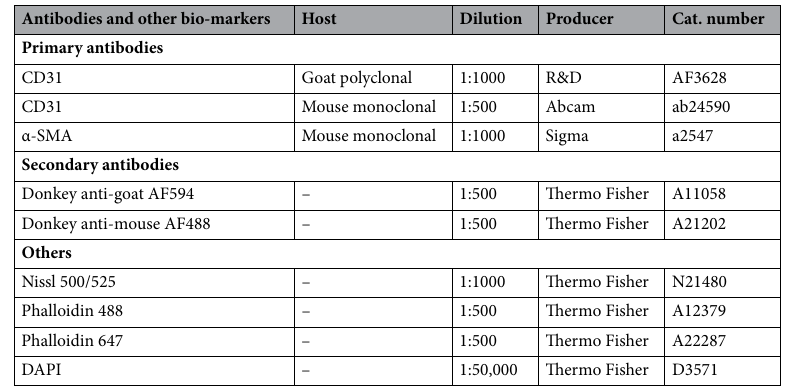
Table 1. List of primary and secondary antibodies, and other bio-markers. α-SMA alpha smooth muscle actin, DAPI 4 ′